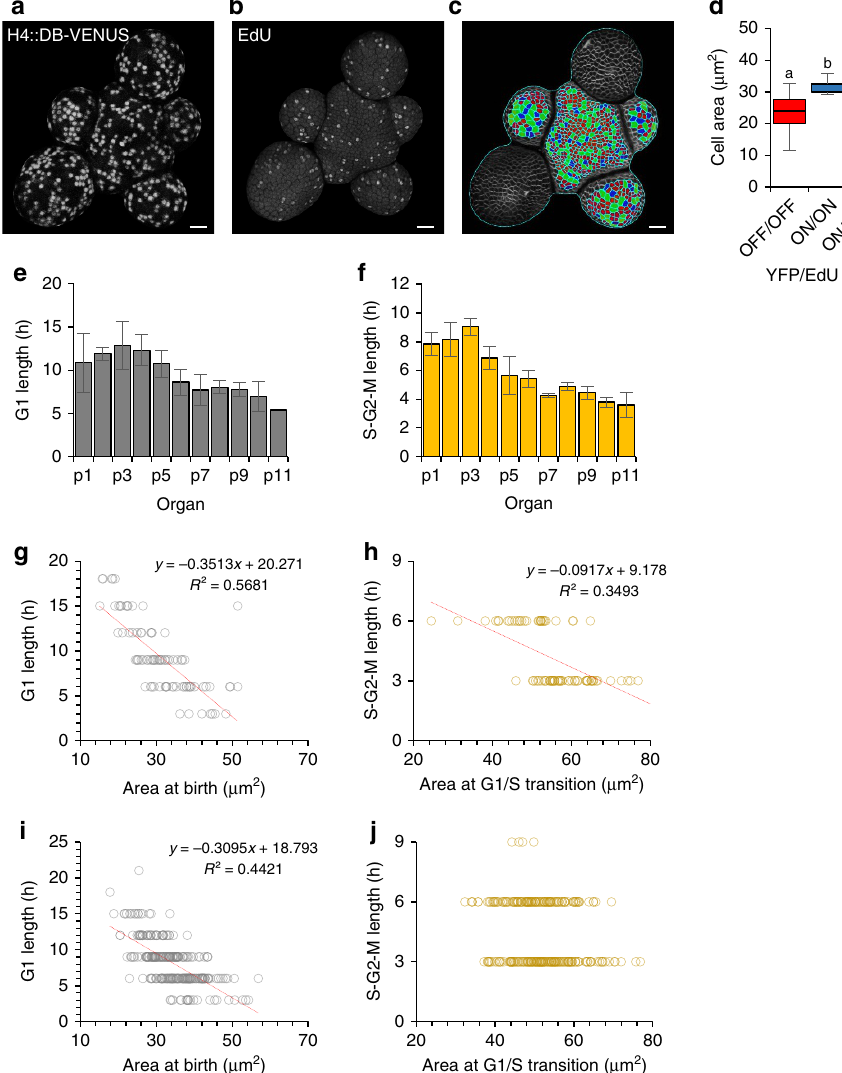
Figure 7 | G1 length and S-G2-M length are both flexible. ( a , c ) Comparison of H4::DB-VENUS expression and pattern of EdU incorporation. Surface projections of VENUS YFP signal ( a ) and EdU-AlexaFluor488 signal ( b ) from the same stem. Segmented image ( c ) identifying cells with no H4::DB-VENUS and no EdU incorporation (red), cells with H4::DB-VENUS and EdU (blue) and cells with only H4::DB-VENUS (green), predicted to be in G1, S and G2-M respectively. Scale bars represent 20 m m. ( d ) Distribution of cell sizes of predicted G1 (red), S (blue) and G2-M cells (green). Boxes represent the interquartile range, whiskers represent total range. ANOVA, n ¼ 516 cells, F(2) ¼ 118.9, P o 0.001, letters indicate significantly different groups based on Tukey’s post hoc analysis. ( e , f ) Mean G1 length ( e ) and S-G2-M length ( f ). Data are grouped by developmental zone. Data shown is the mean from three stems and error bars represent s.d. ( g – j ) Relationship between cell area and phase lengths in young (p1–p5) ( g , h ) and old (p6–p10) ( i , j )